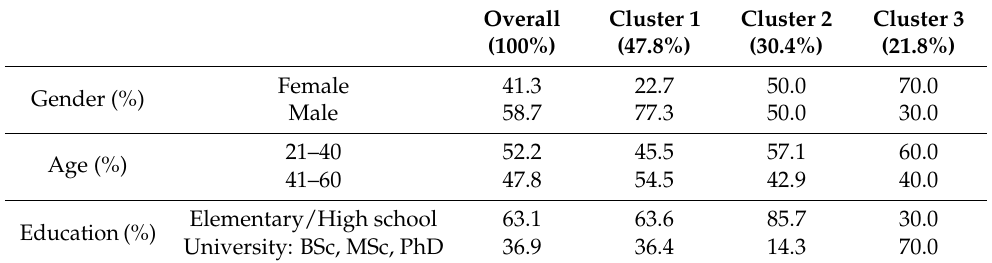
Table 5. Structure of a cluster membership.